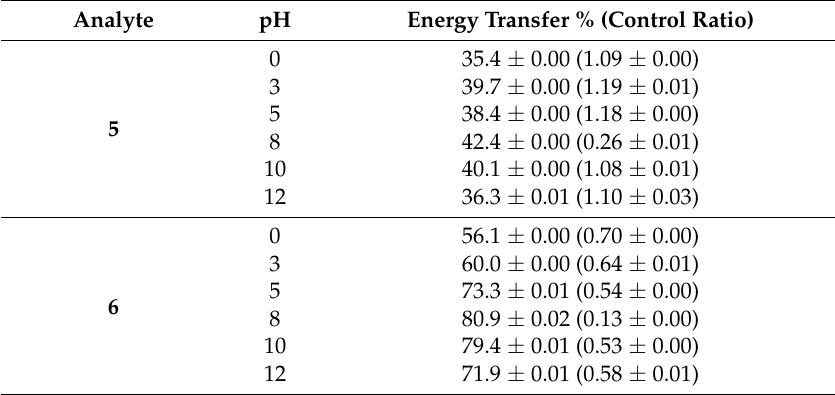
Figure 5. A comparison of the fluorescence emission in γ-cyclodextrin at pH 0 (black line) and pH 8 (red line), and pH 12 (blue line) with ( A ) analyte 5 ; and ( B ) analyte 6 with fluorophore 7 . Insets show the zoomed-in spectral region from 470–800 nm. Table 3. Select results of energy-transfer experiments with compound 7 (control ratios shown in parentheses) a .